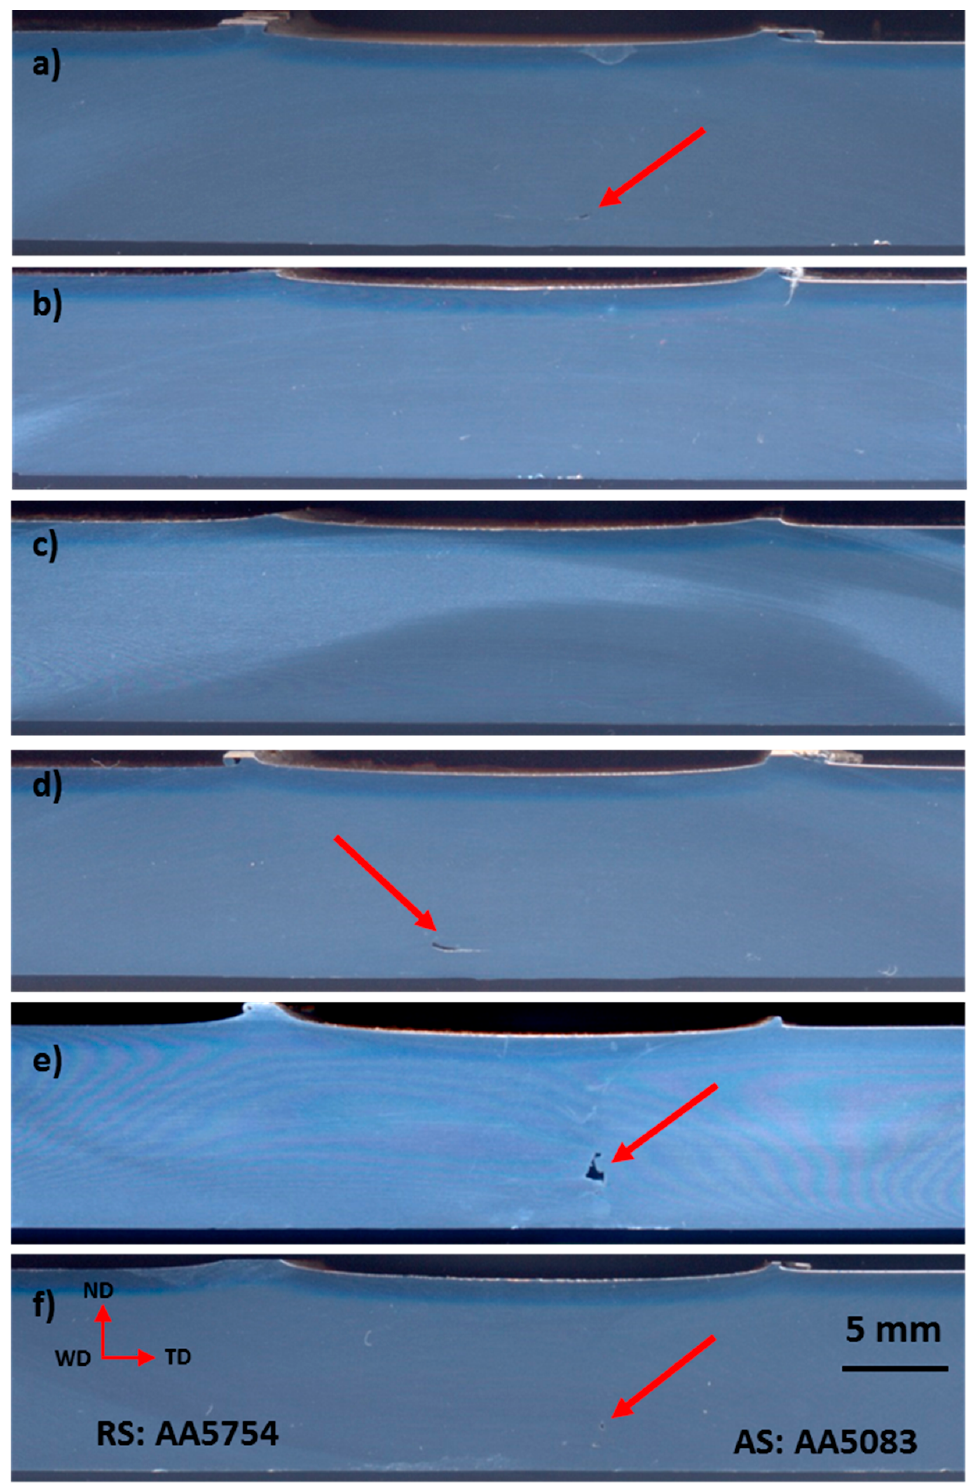
Figure 7. Polishing cross-sections of friction stir welded joints AA5083/AA5754 at different rotational and traverse speeds. Arrows refer to the tunnel defects: ( a ) 400 rpm, 20 mm/min, ( b ) 400 rpm, 40 mm/min, ( c ) 400 rpm, 60 mm/min, ( d ) 600 rpm, 20 mm/min, ( e ) 600 rpm, 40 mm/min and ( f ) 600 rpm, 60 mm/min.